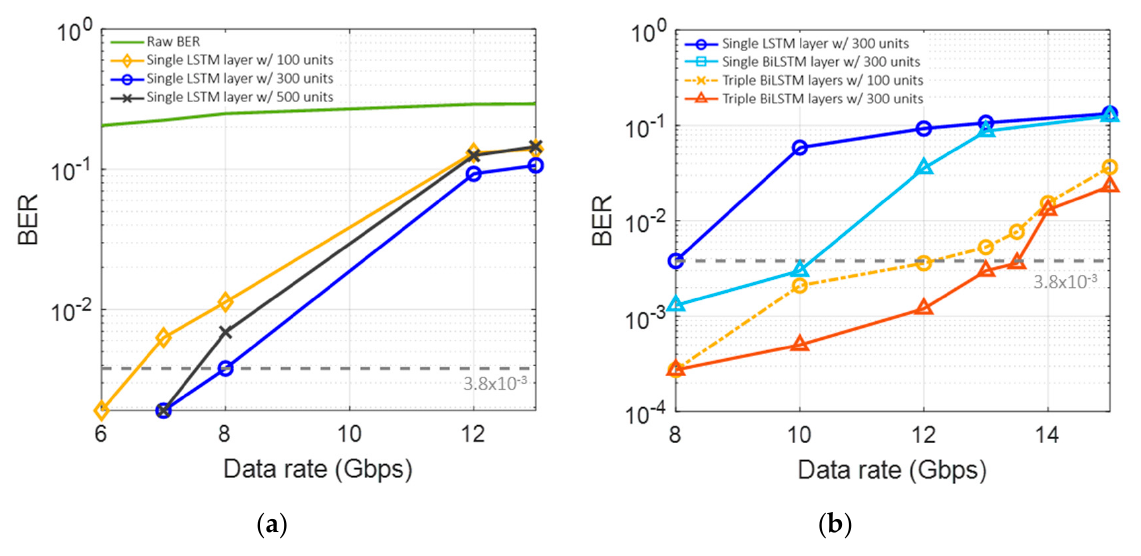
Figure 10. BER performances ( a ) by the number of units, ( b ) by the number of layers and types.